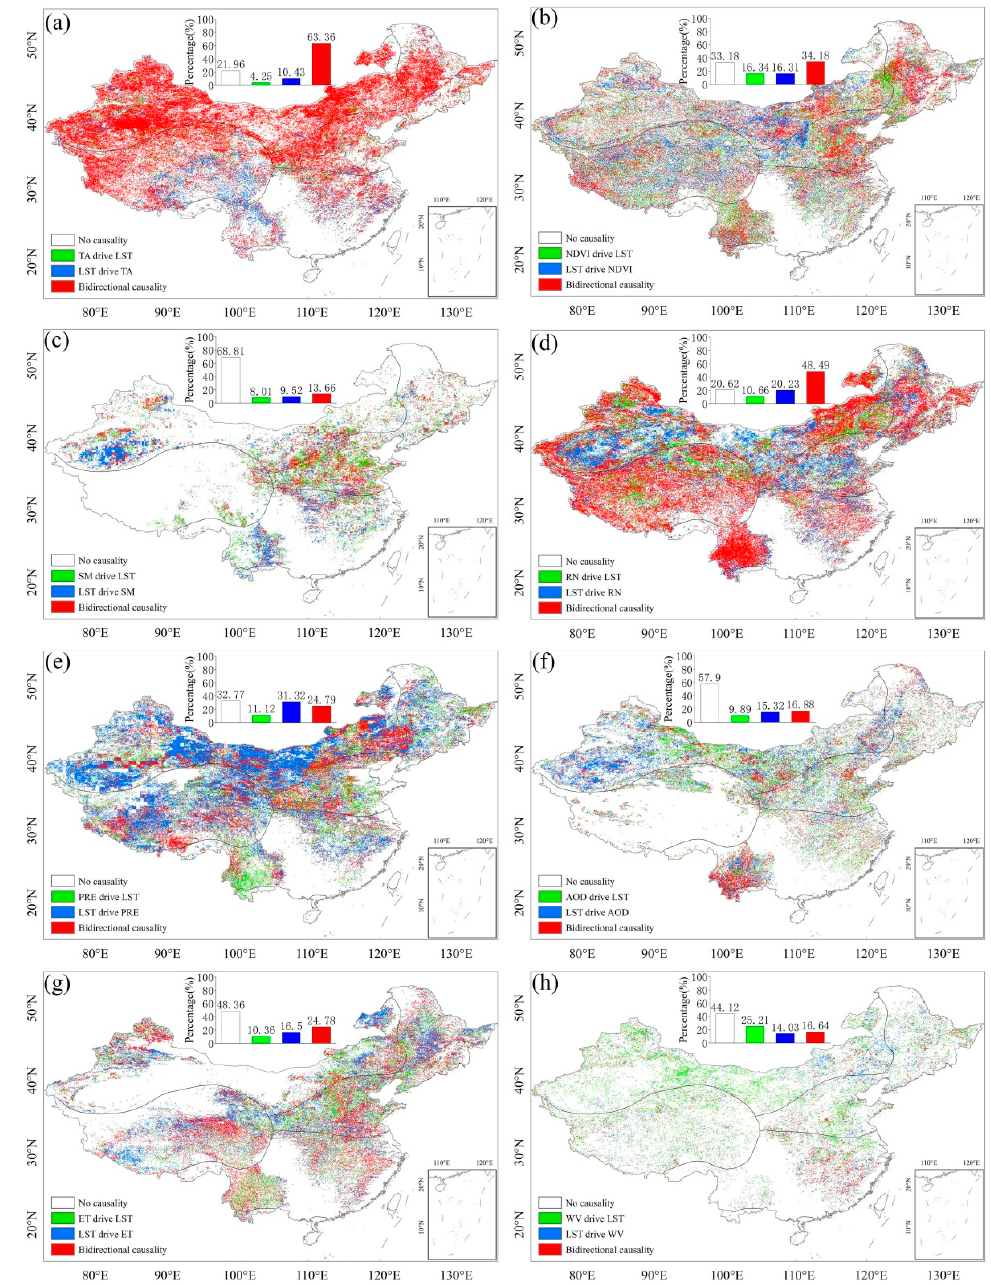
Figure 15. Spatial distribution of the types of causality between LST and environmental factors. ( a ) TA ( b ) NDVI ( c ) SM ( d ) RN ( e ) PRE ( f ) AOD ( g ) ET ( h ) WV. Green areas indicate environmental factor-driven LST types, blue areas indicate LST-driven environmental factor types, and red areas indicate bidirectional causality types, and the blank areas indicate pixels with no causal relationship.